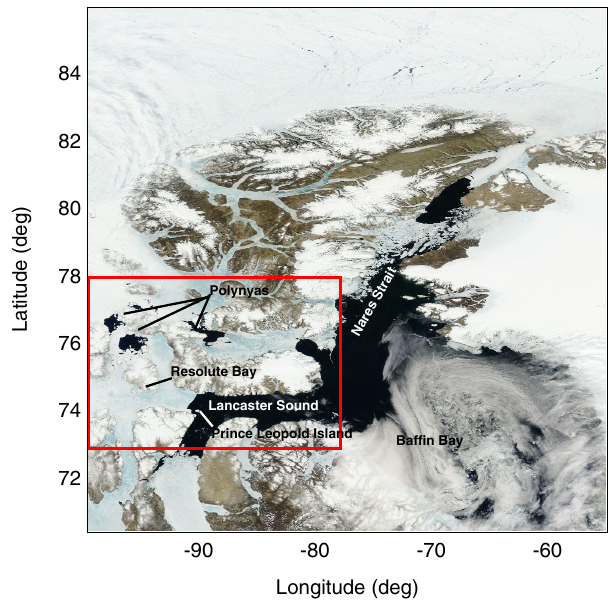
Figure 1. Satellite image (visible range from MODIS) from 4 July 2014 showing sea ice and open water conditions around Resolute Bay, in Lancaster Sound, Nares Strait and Baffin Bay. The red box indicates the region expanded with flight tracks in Fig. 2. The image is courtesy of NASA Worldview: https://worldview.earthdata.nasa.gov.